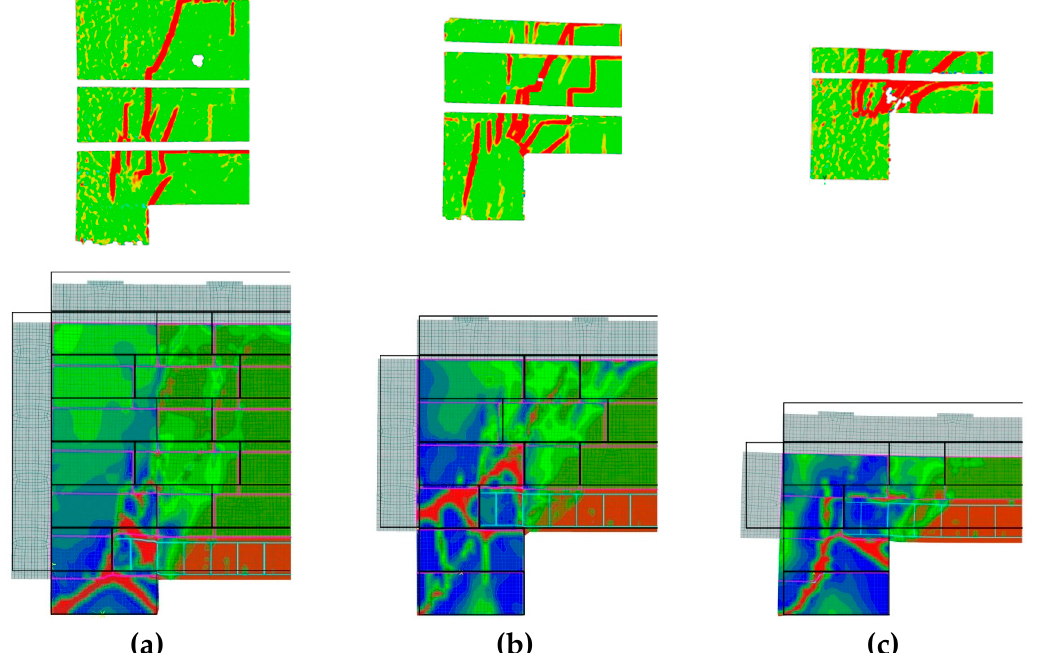
Figure 18. Damage recorded by the optical system compared with the damage to the numerical model for the elements of the following series: ( a ) NI, ( b ) NII, ( c ) NIII.